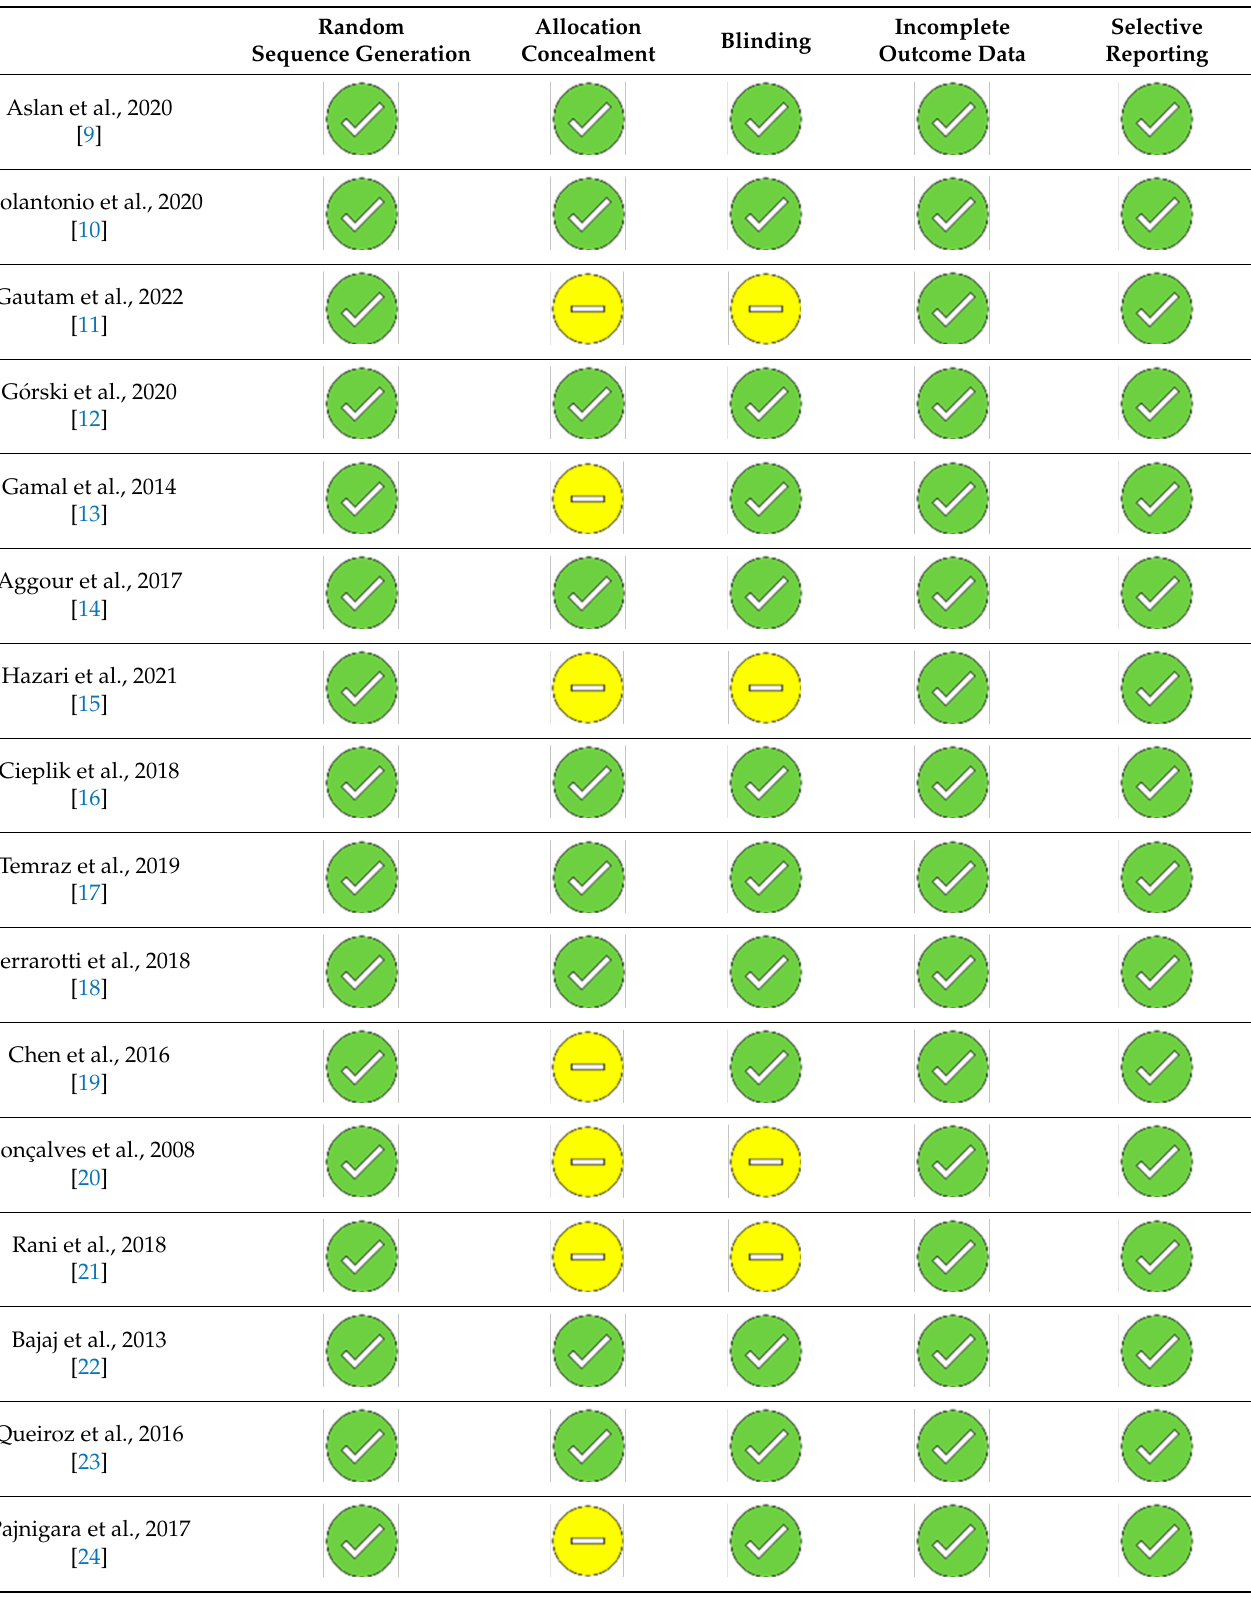
Table 1. Risk of bias of the studies included in this review: the green symbol represents a low risk of bias, while the yellow symbol represents a high risk of